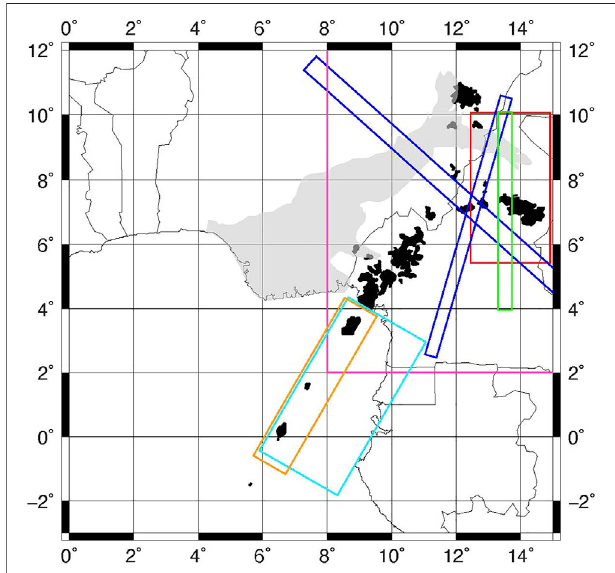
FIGURE 3 | Locations of select geophysical studies from 1985 to 1999. Red = Areal extent of Stuart et al. (1985) and Dorbath et al. (1986); Royal Blue = Cross-sections from Okereke (1988); Magenta = Focus area of Poudjom Djomani et al. (1995); Green = Cross-section from Poudjom Djomani et al. (1997); Cyan = Focus area of Meyers and Rosendahl (1991); Orange = Focus area of Meyers et al.